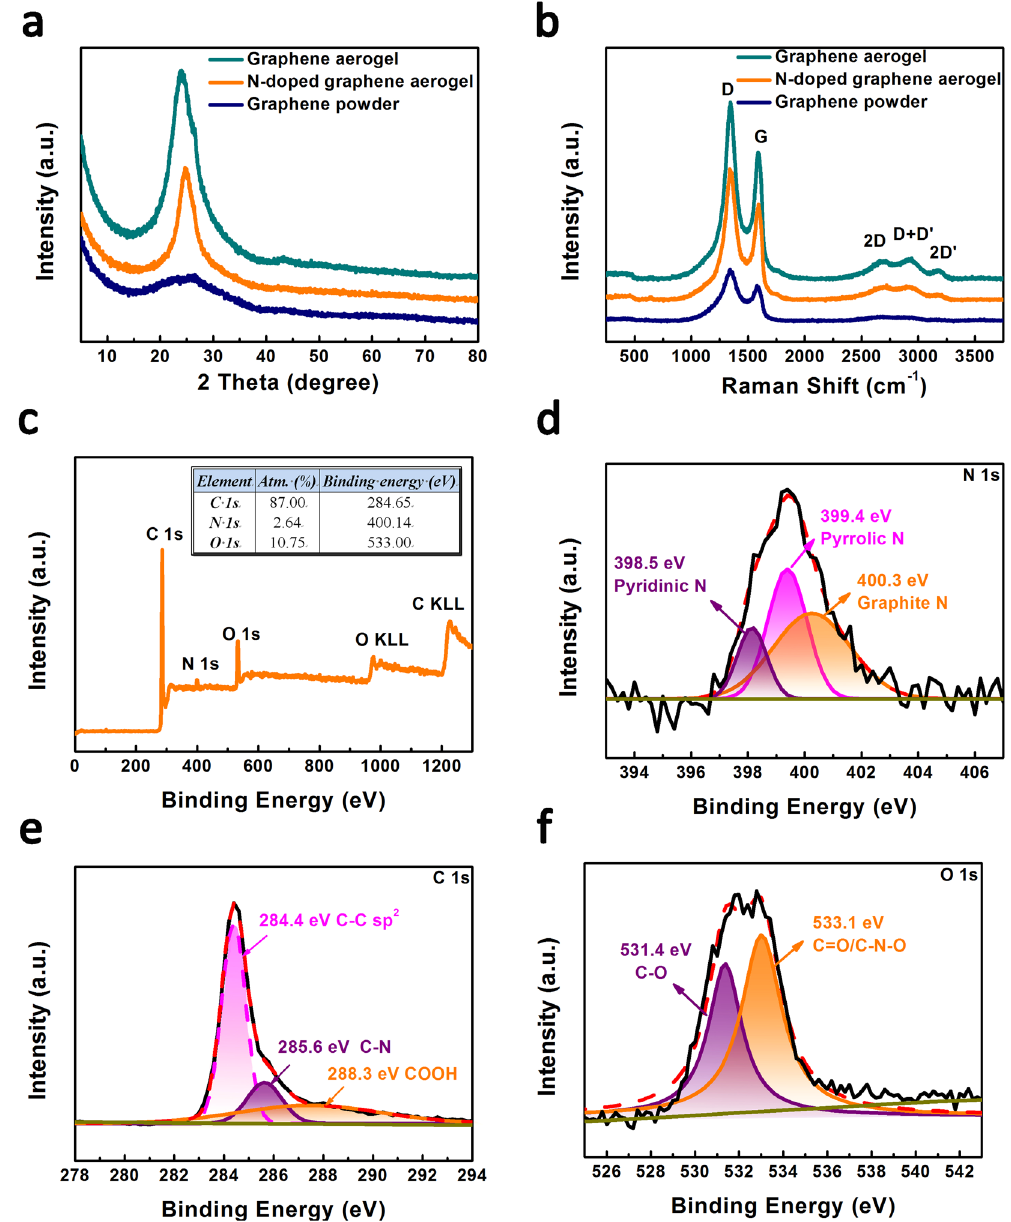
Figure 3. ( a ) Powder X-ray diffraction patterns and ( b ) Raman spectra of the graphene powder, graphene aerogel, and N-doped graphene aerogel samples; ( c ) the XPS survey spectrum of the N-doped graphene aerogel. The inset is the elemental analysis; curve fittings of ( d ) N 1s, ( e ) C 1s and ( f ) O 1s XPS spectra in the N-doped graphene